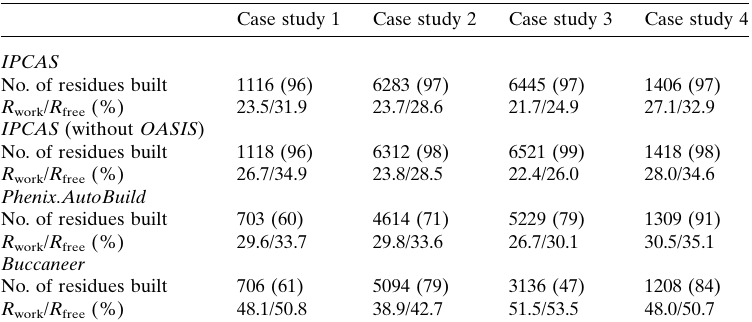
Table 3 Phase-extension and model-completion results. The numbers in parentheses for the number of residues built are given as